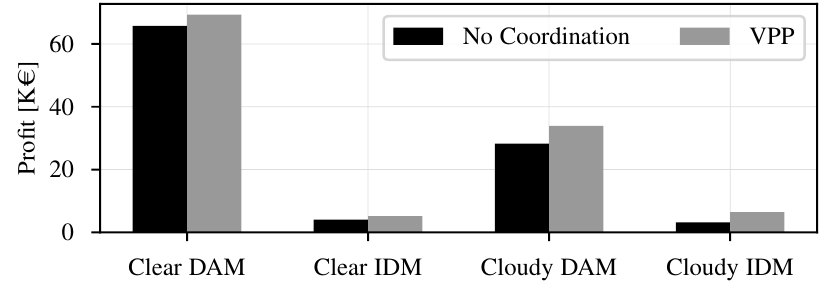
Figure 7. VPP benefits on different